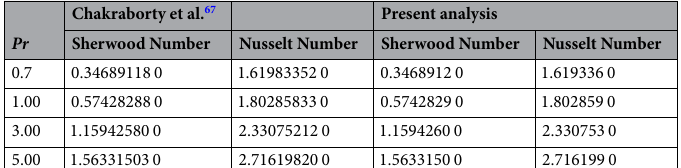
Table 3. Comparative results of Sherwood and Nusselt number for different values of Pr and rest of physical values